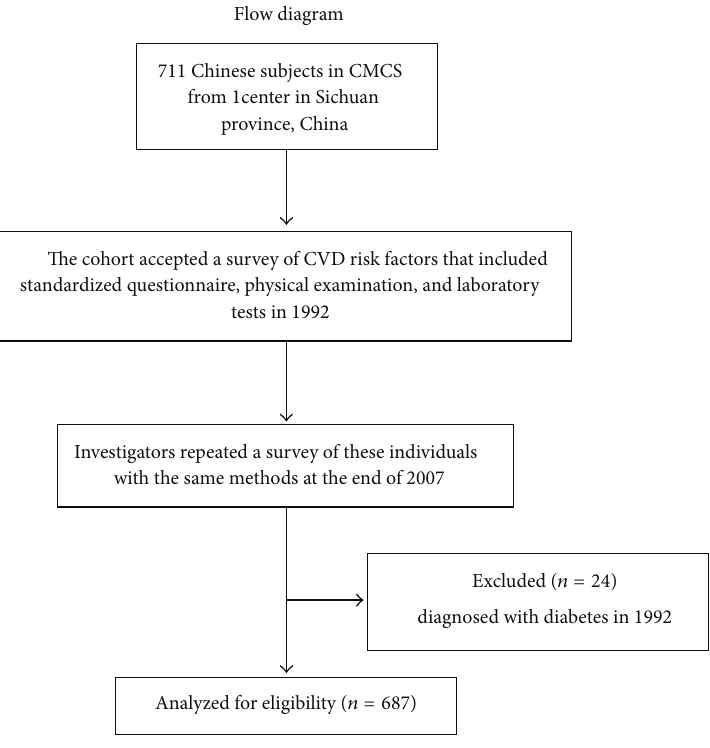
Figure 1: The flow chart of the